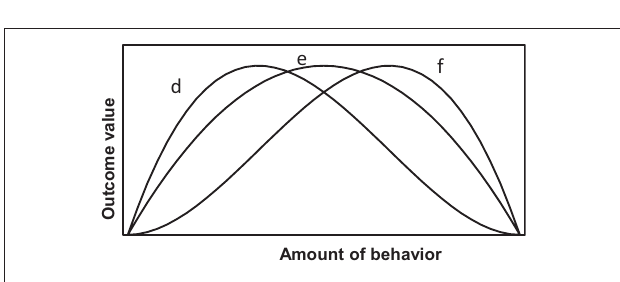
FiGuRe 1 | Relationships between the behavior and its outcome value; a: the more, the better; b: the less, the better; c: not too much and not too little.